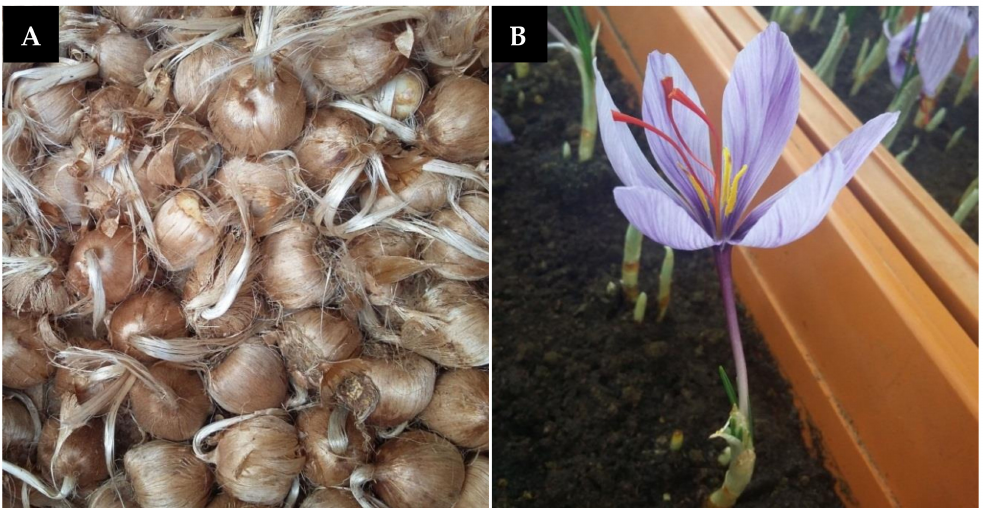
Figure 1. Main components of sa ff ron ( Crocus sativus ), ( A ) corms ( B )